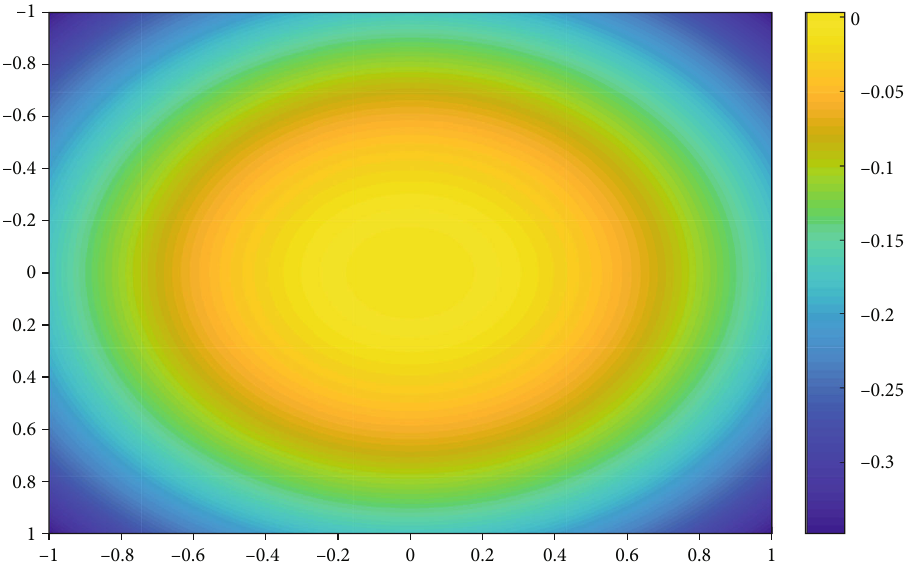
Figure 1: Errors of approximation of network operators (6) with n = 100 :